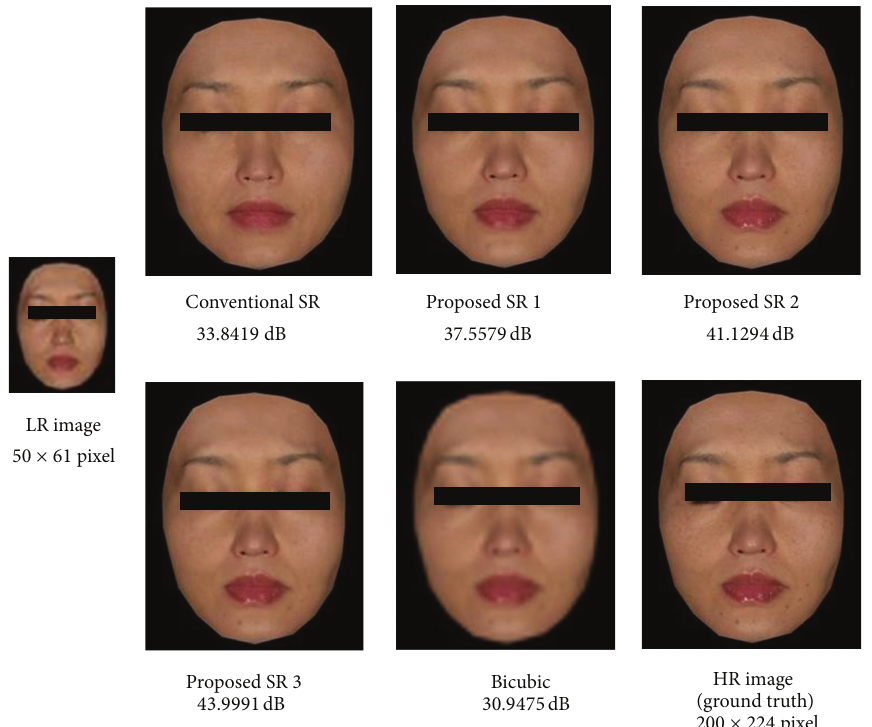
Figure 7: Typical reconstructed images for an aligned face image database